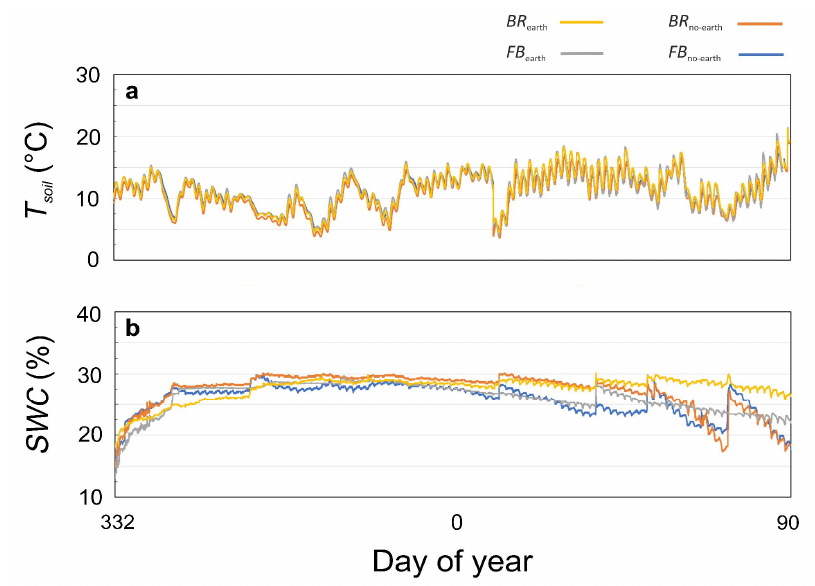
Figure 1. ( a ) Soil water content ( SWC ) and ( b ) soil temperature ( T soil ) measured throughout the experimental period in soils under different treatments, consisting of broccoli with earthworms ( BR earth : yellow), broccoli without earthworms ( BR no-earth : red), faba bean with earthworms ( FB earth : grey), and faba bean without earthworms ( FB no-earth : blue).